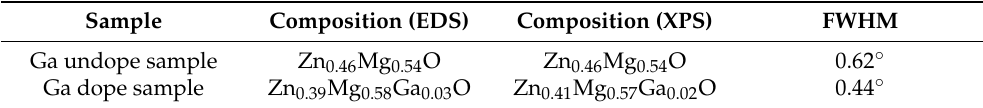
Table 1. Structure properties of ZnMgO sample.